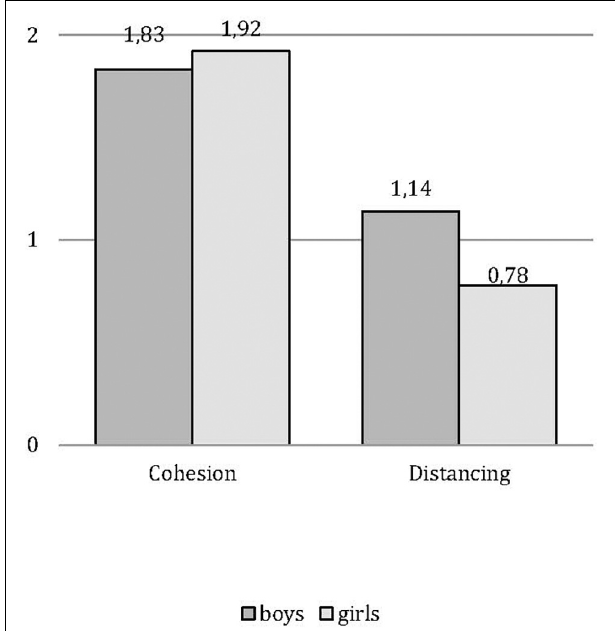
FIGURE 2 | Cohesion and distancing in wellbeing by gender.